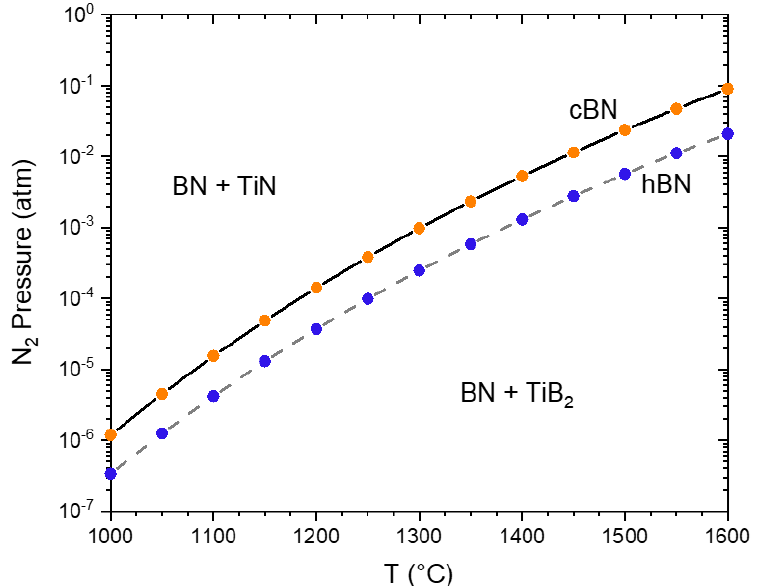
Figure 13. Nitrogen equilibrium pressure as a function of temperature for reaction (1) and (2). The stability area of the TiN and TiB 2 phases are shown.